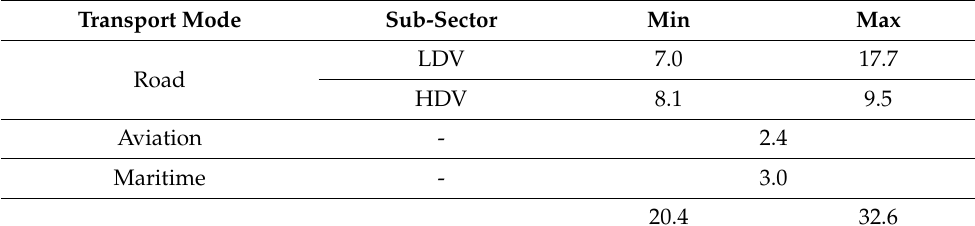
Table 2. Expected alternative fuel demand per transport mode (Mtoe) in